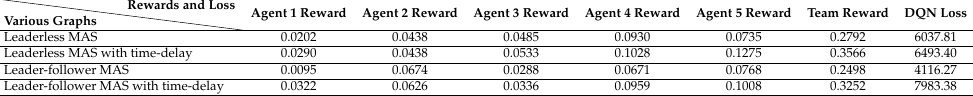
Table 2. Comparison of each agent’s average reward and DQN loss of a heterogeneous MAS, including N = 5 agents in P = 3 different clusters, during 20,000 time steps by considering the novel distance-based reward.